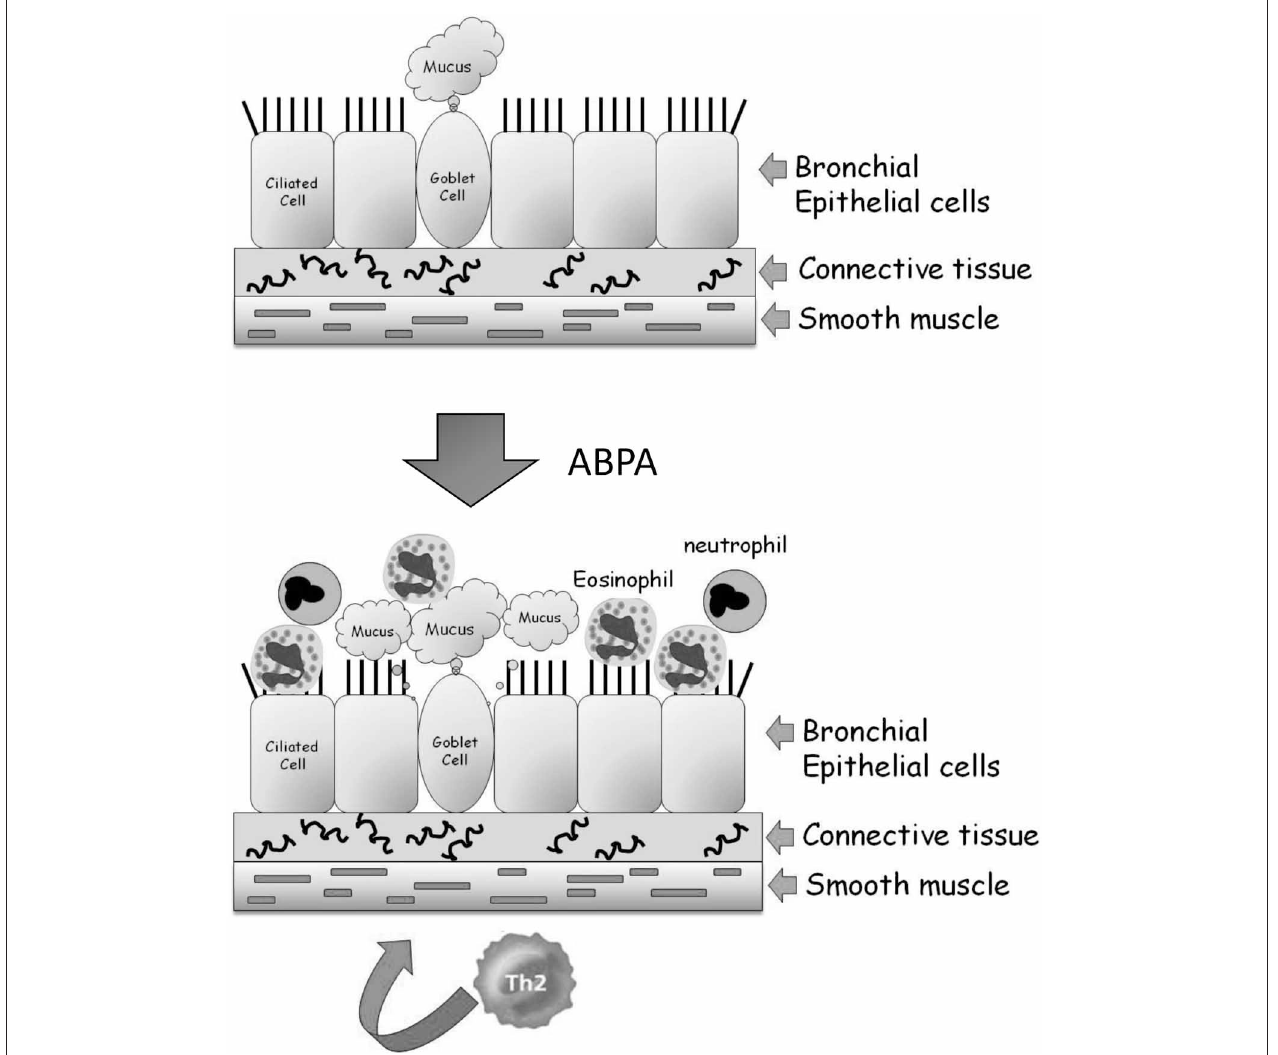
FIGURE 1 | Structure of the lung airways and the development of ABPA. The major epithelial cell types in the airways are the ciliated, goblet, and basal cells. They are attached to connective tissue that is surrounded by a band of smooth muscle cells. In ABPA, a Th2-mediated response to inhaled